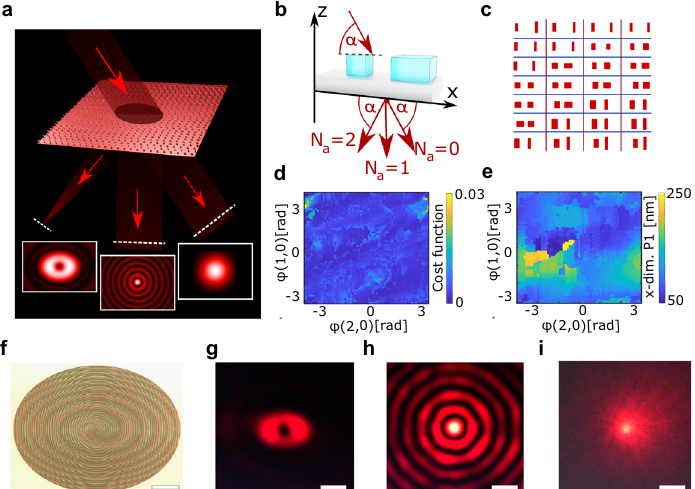
Fig. 2 Multifunctional beam shaping supercell metasurface (SCMS). a Schematic and simulation results. The collimated input beam has a gaussian pro fi le and impinges under a steep angle (52°). The SCMS splits the beam into a gaussian, a Bessel- and a focused helical beam while introducing a de fl ection of 0°, 52° and 104°, respectively. b Schematic of the two-pillar supercell. c Schematic of a metasurface detail. All supercells have the dimension of 800 nm × 400 nm. d Optimization results of the supercell library showing the cost function for a 2 π phase coverage on the orders (1,0) and (2,0). e Optimization results of the supercell library showing the x -dimension of the fi rst pillar for a 2 π phase coverage on the orders (1,0) and (2,0). f Optical image of the fabricated SCMS. Scale bar 165 µ m. g Optical measurement of the focused helical beam. Scale bar: 8 µ m. h Optical measurement of the Bessel beam. Scale bar: 8 µ m. i Optical measurement of the 0th order in the far fi